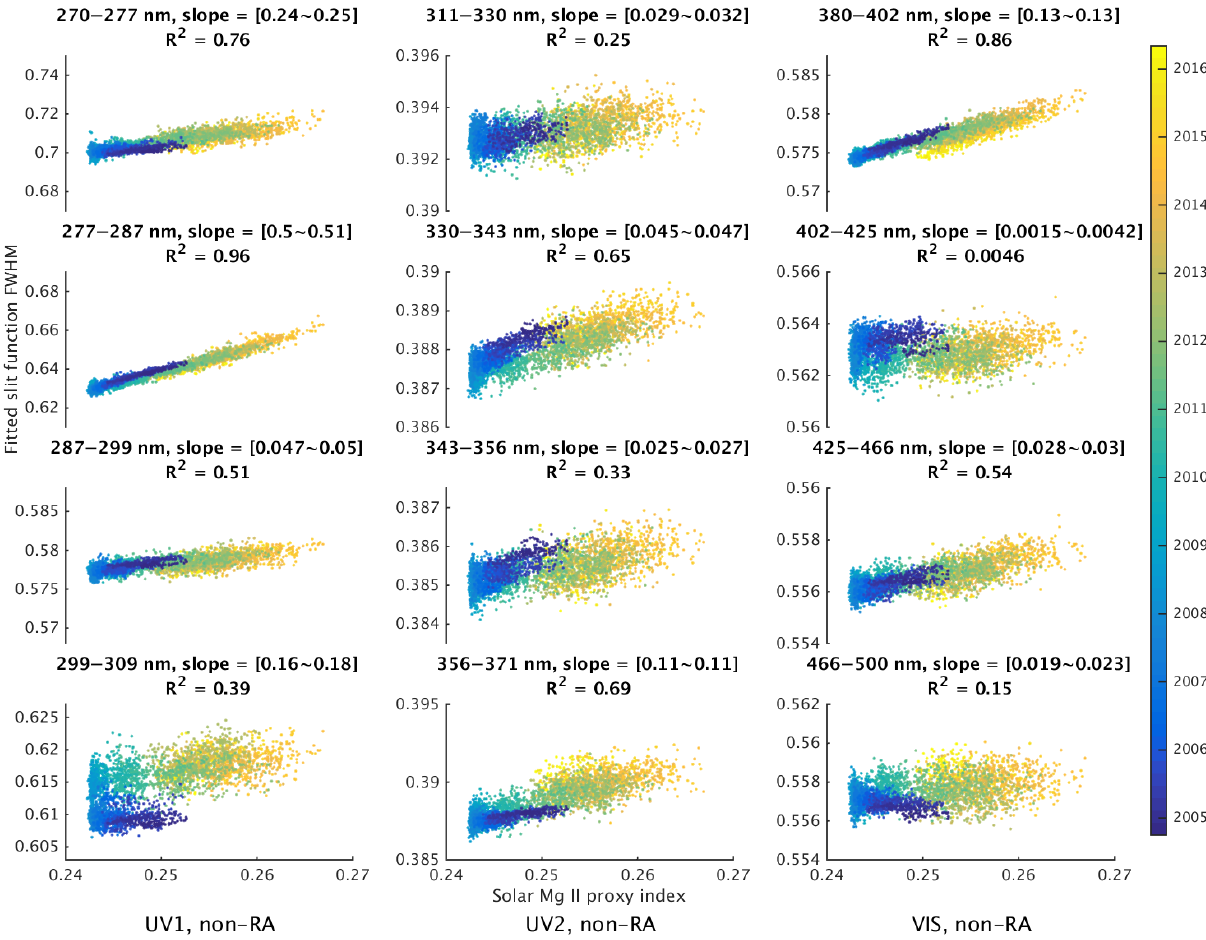
Figure 5. Scatter plots between the average slit function FWHM of all non-RA rows (assuming standard Gaussian) and the Mg II index. The columns and rows are the same as Fig. 4. The linear fitting slopes between the normalized slit function widths and the normalized Mg II index are shown in the title of each